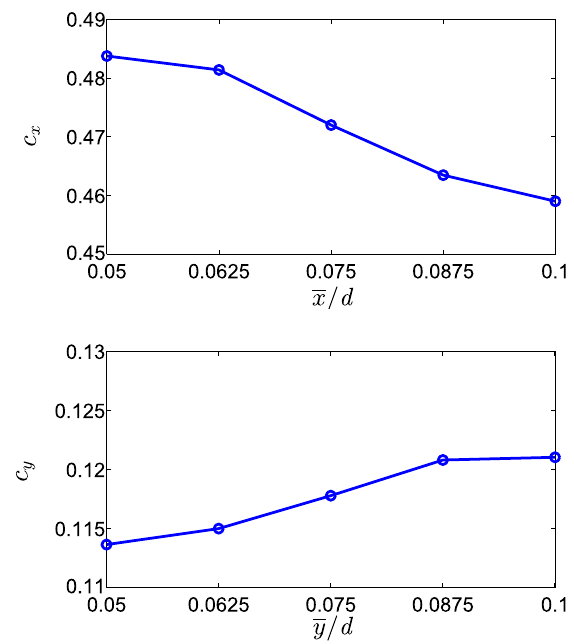
FIG. 13. Quadrupole signal Ξ (above) Ξ as a function of ¯ x=d , ¯ y ¼ 0 ; (below) Ξ as a function of ¯ y=d